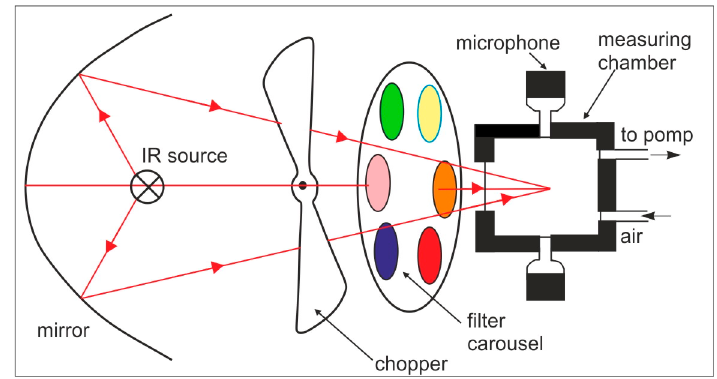
Figure 13. Diagram of the Innova 1312 photoacoustic analyzer.